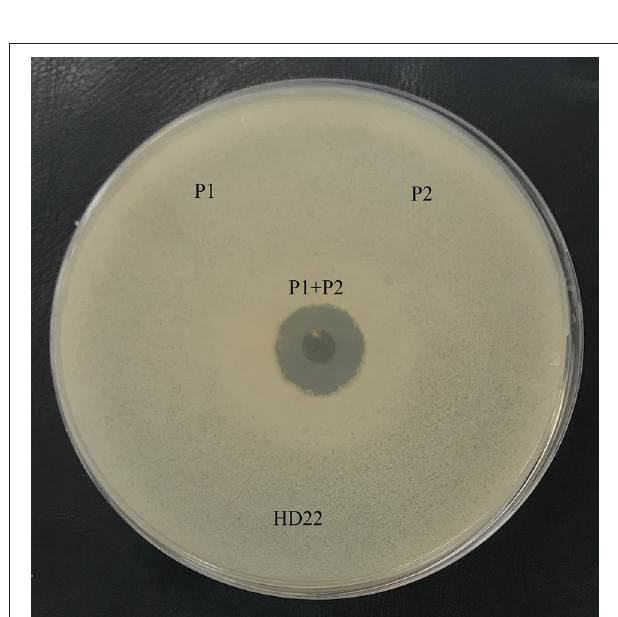
FIGURE 4 | Antimicrobial activity of the fraction with caseinase activity, P1: protease 1 (fraction 30-33), P2: protease 2 (fraction 36–39). B. thuringiensis HD22 was used as the indicator